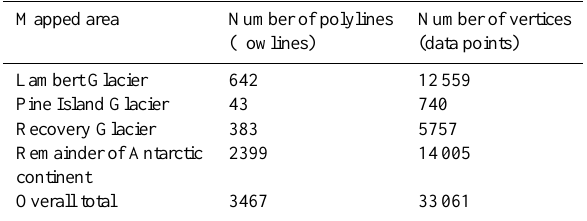
Table 1. Details of the data set created from mapping the longitu- dinal ice-surface structures of the Antarctic ice